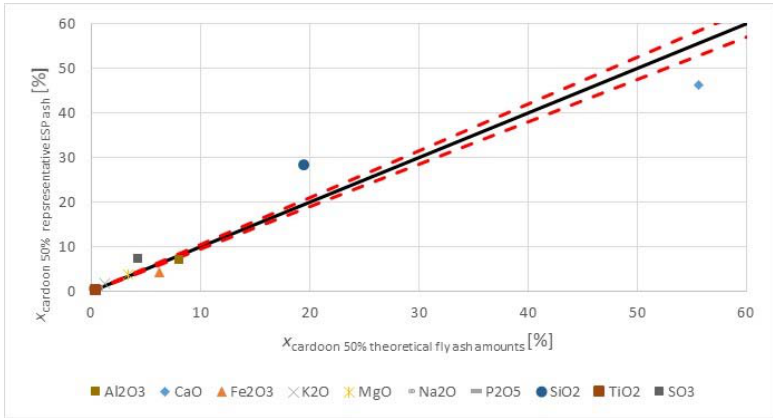
Figure 11. Enrichment of elements in the fly ash for 50% thermal share of Cynara ; fuel ash blend plotted on the abscissa and representative ESP ash plotted on the ordinate; dashed lines estimate the uncertainty due to analyses variability ( ±